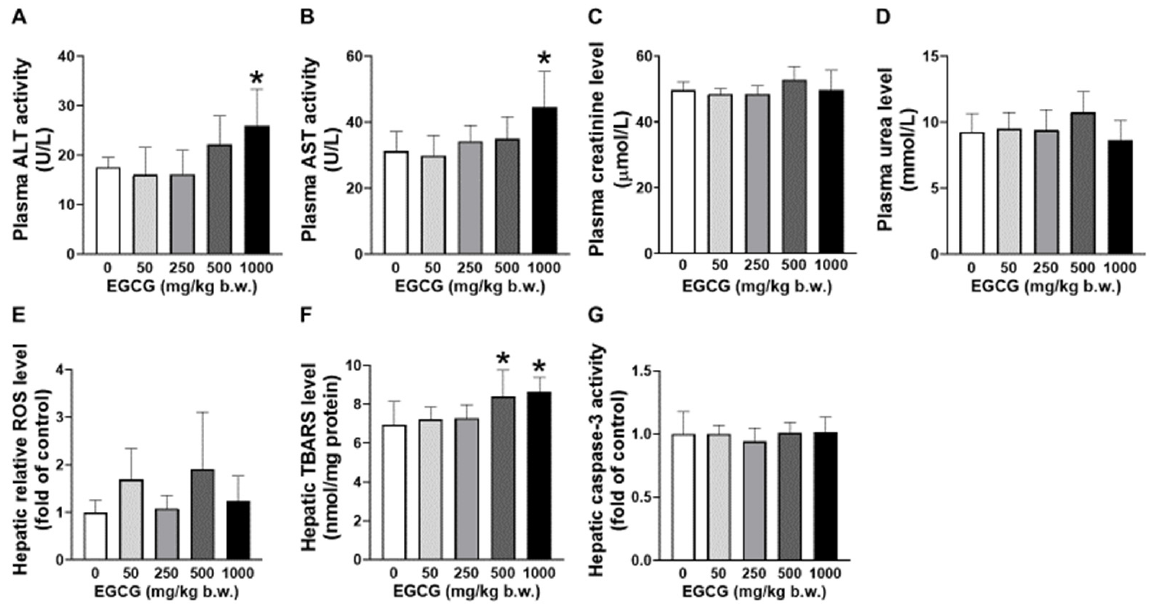
Figure 1. Effect of EGCG at different concentrations on the plasma ( A ) AST, ( B ) ALT, ( C ) creatinine, ( D ) urea and hepatic ( E ) ROS, ( F ) TBARS, and ( G ) caspase-3 of SHR. Data were expressed as mean ± SD, n = 6. * p < 0.05 vs. vehicle, one-way ANOVA followed by Dunnett’s test. ALT: alanine ami- notransferase, AST: aspartate aminotransferase, ROS: reactive oxygen species, TBARS: thiobarbitu- ric acid reactive substances.